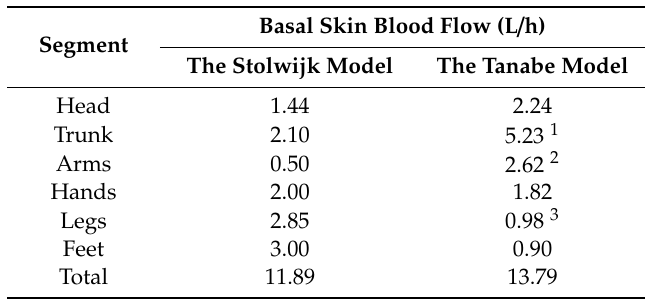
Table 8. Basal skin blood flow in the Stolwijk model and the Tanabe